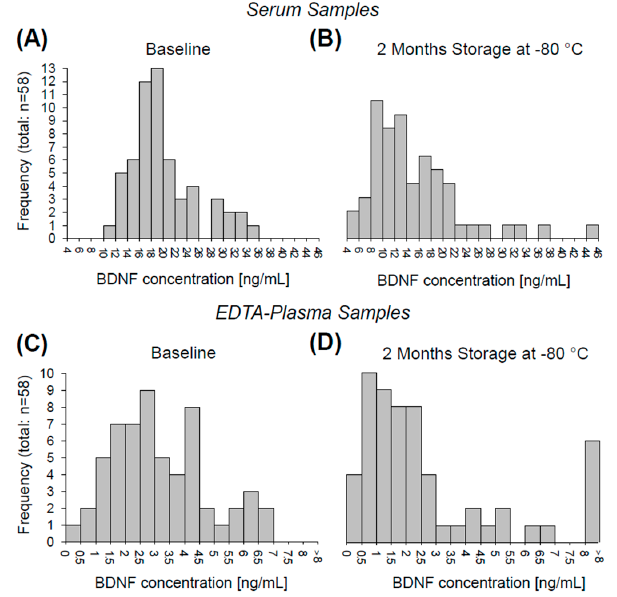
Figure A1. Histograms for BDNF concentrations in serum and EDTA-plasma at “Baseline” (T1) ( A , C ) and “2 months storage at − 80 °C” (T4) ( B , D ). BDNF: brain-derived neurotrophic factor, EDTA: ethylenediaminetetraacetic acid.